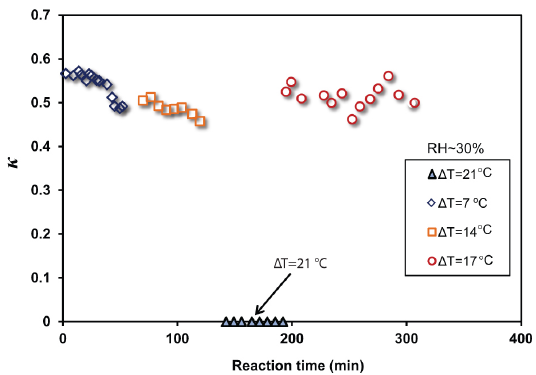
Figure 4. Measured κ values at ss ∼ 0.38% for butylamine (BA) + N 2 O 5 aerosol formed at RH ∼ 30%. Symbols represent var- ious temperature difference ( 1T ) between the top and bottom of the CCN counter